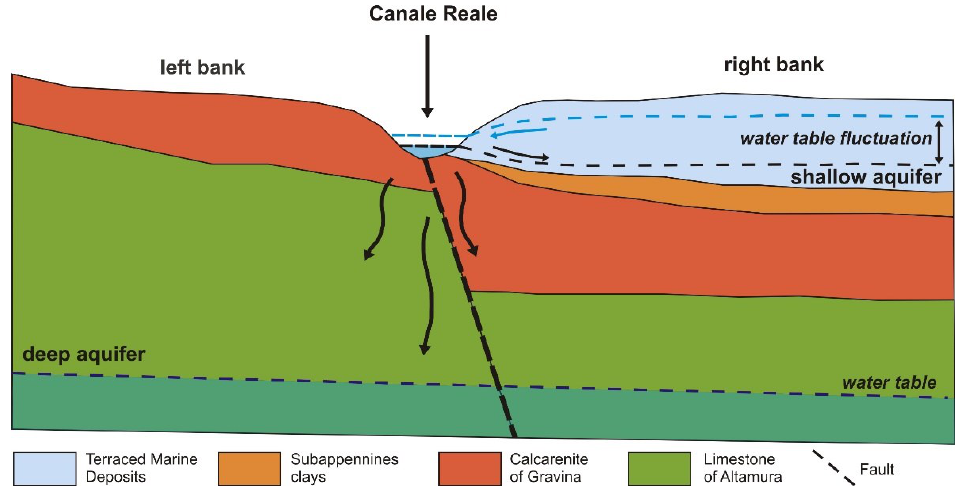
Figure 3. Schematic cross-section of Canale Reale River showing the different types of interaction between SW and GW: on the left side is the case of a losing stream, on the right one is the case of a gaining stream that can turn into a losing stream, and vice versa, according to water table fluctua- tions.